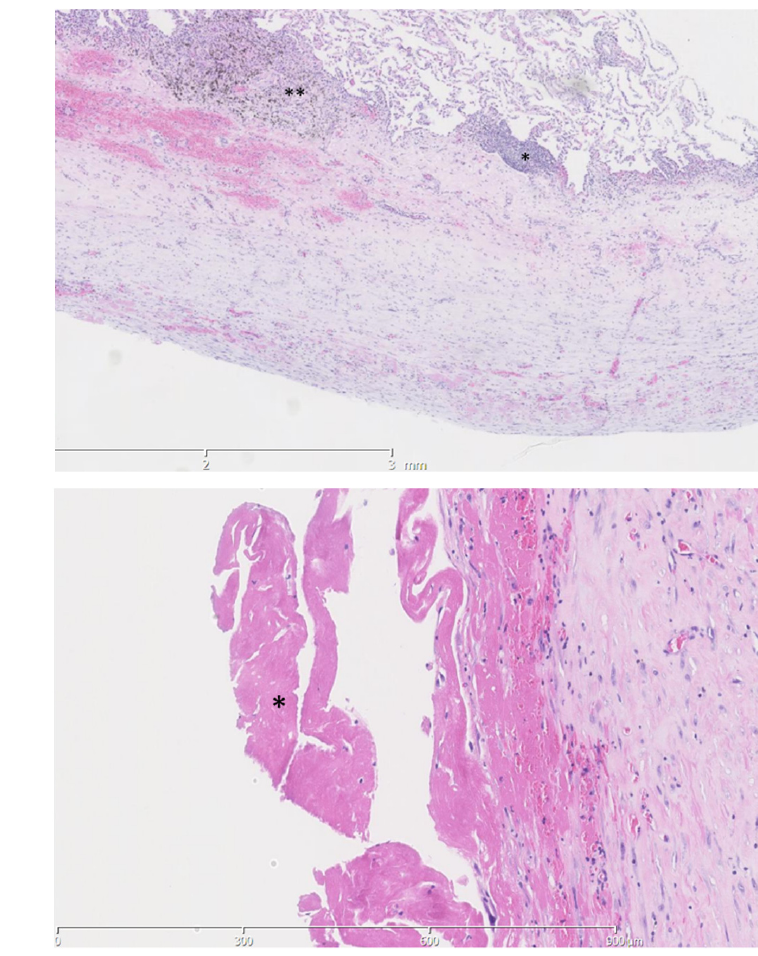
Figure 3. Histopathologic slides of the pleura. ( a ). Thickening of the pleura is seen with a subpleural mononuclear inflammatory infiltrate (*) and anthracosilicotic changes (**) ( b ). A fibrinous exsudate (*) is seen at the pleural surface.